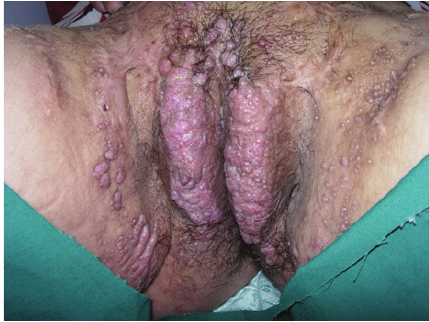
Figure 2: Widespread papules and vesicles on the pubis, labia majora, and inguinal region.